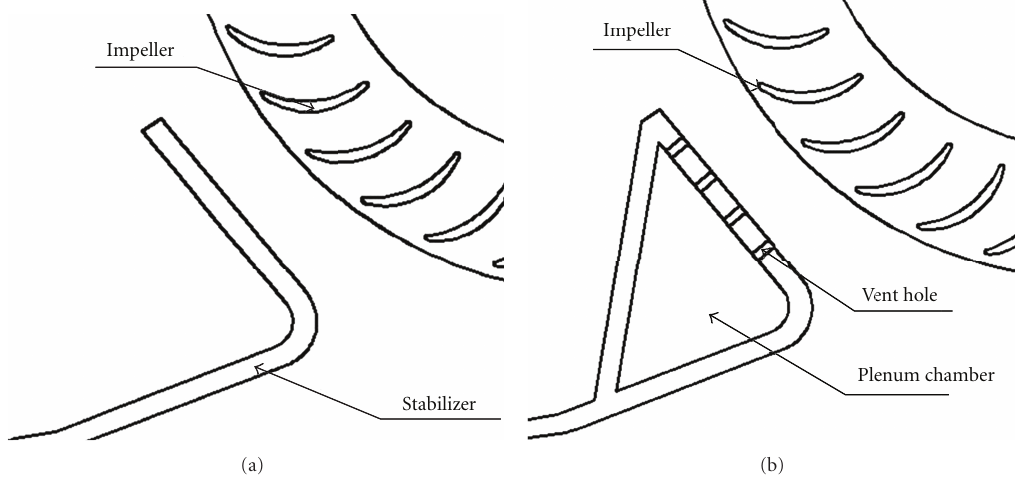
Figure 2: Stabilizer of cross-flow fan. (a) The original folded-plate stabilizer. (b) The porous stabilizer with plenum and vent holes.